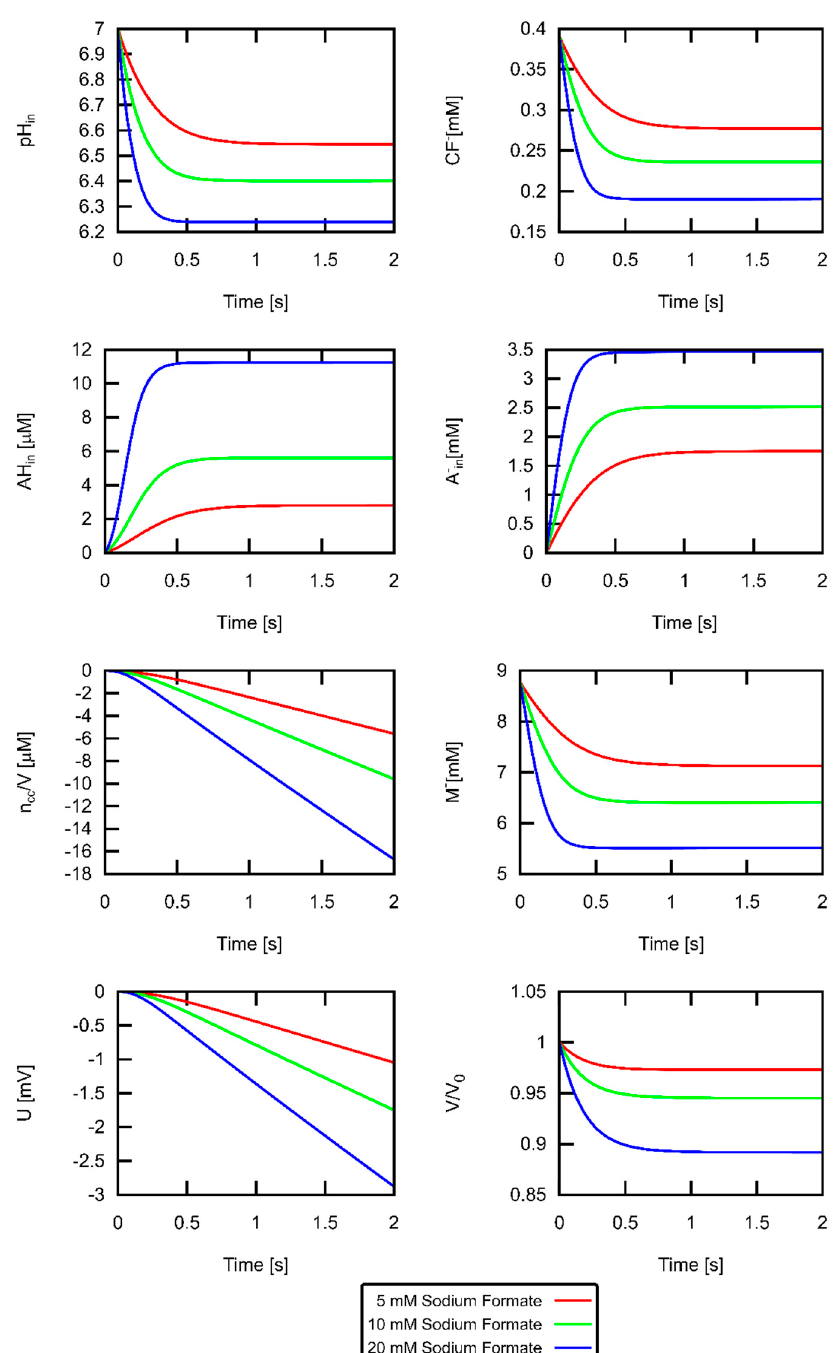
Figure 6. The effect of external weak acid concentration on acid uptake, vesicle volume and membrane voltage. Quantities ( 𝑝𝐻 (cid:3036)(cid:3041) , concentration of unprotonated dye [𝐶𝐹 (cid:2879) ] , relative vesicle volume 𝑉/𝑉 (cid:2868) , concentration of protonated and deprotonated acid [𝐴𝐻] (cid:3036)(cid:3041) , [𝐴 (cid:2879) ] (cid:3036)(cid:3041) , net concentration of protons that have permeated 𝑛 (cid:3030)(cid:3030) /𝑉 , concentration of unprotonated buffer [𝑀 (cid:2879) ] , and the transmembrane potential 𝑈 ) extracted from the fit of 𝐼 (cid:3047)(cid:3035)(cid:3032)(cid:3042)(cid:3045) to 𝐼 (cid:3032)(cid:3051)(cid:3043) in Figure 4 (middle panel, 10 mM MES). The sodium formate gradient is denoted in the key.